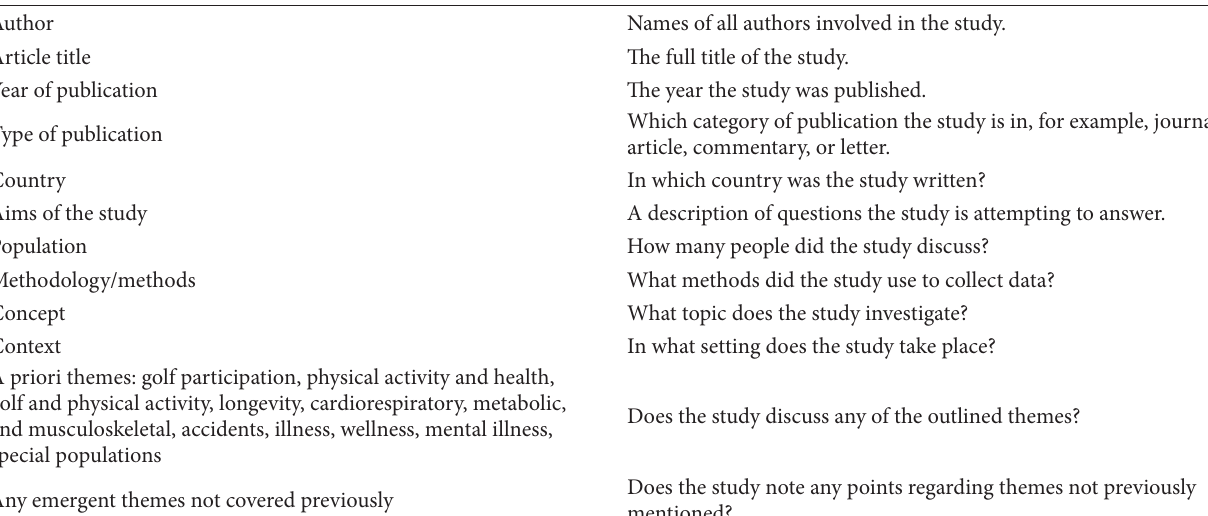
Table 1: Criteria used to extract data.